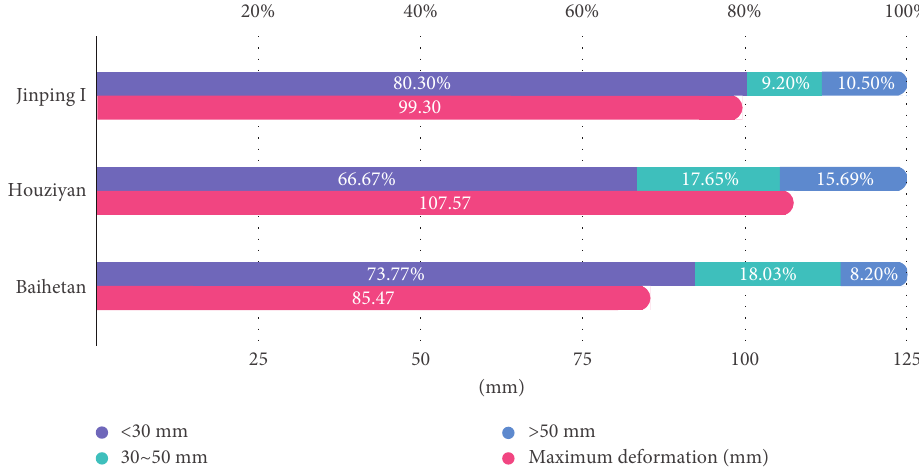
Figure 10: Statistical results of surrounding rock mass deformation for the three main powerhouses.